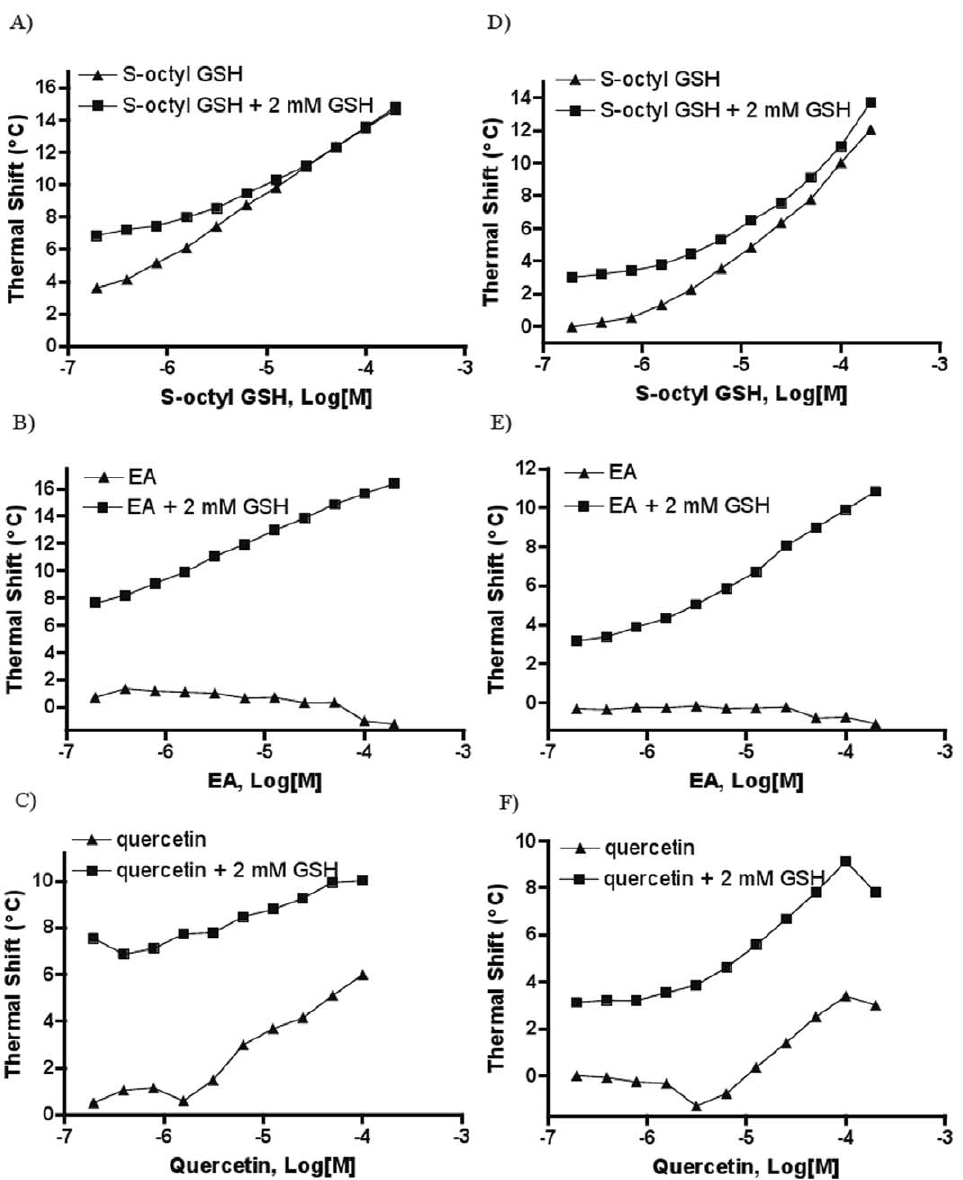
Figure 7. Thermal shift concentration-response curves using hGSTA1-1 in the absence and presence of 2 mM GSH for A) S-octyl GSH, B) ethacrynic acid (EA), C) quercetin, and using hGSTM1-1 for D) S-octyl GSH, E) EA, and F) quercetin. Thermal shifts represent the differences in T m between vehicle control and compound-containing samples, respectively.